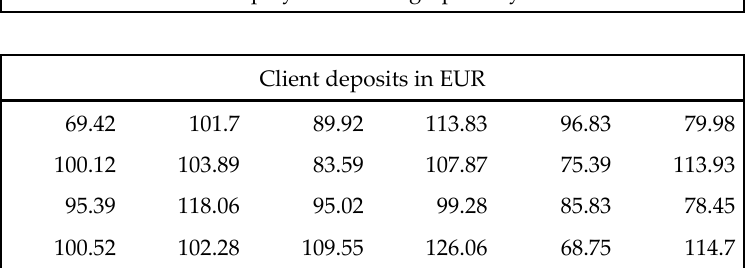
Figure 4. A sample of the semester project